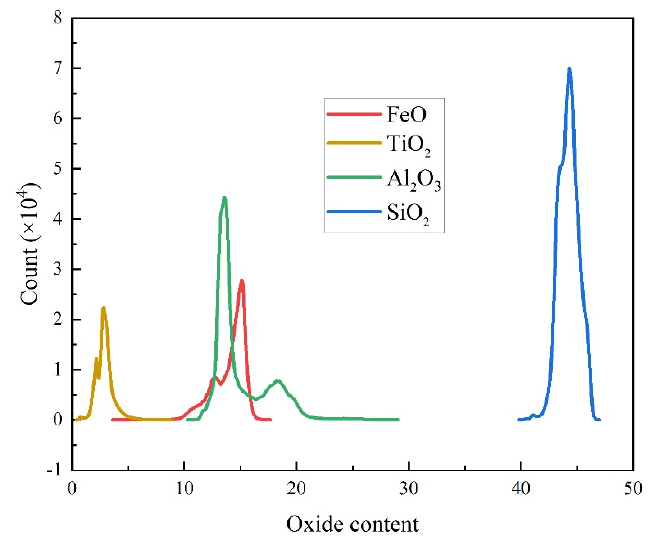
Figure 14. Smoothed histograms of four oxide contents in the study area.